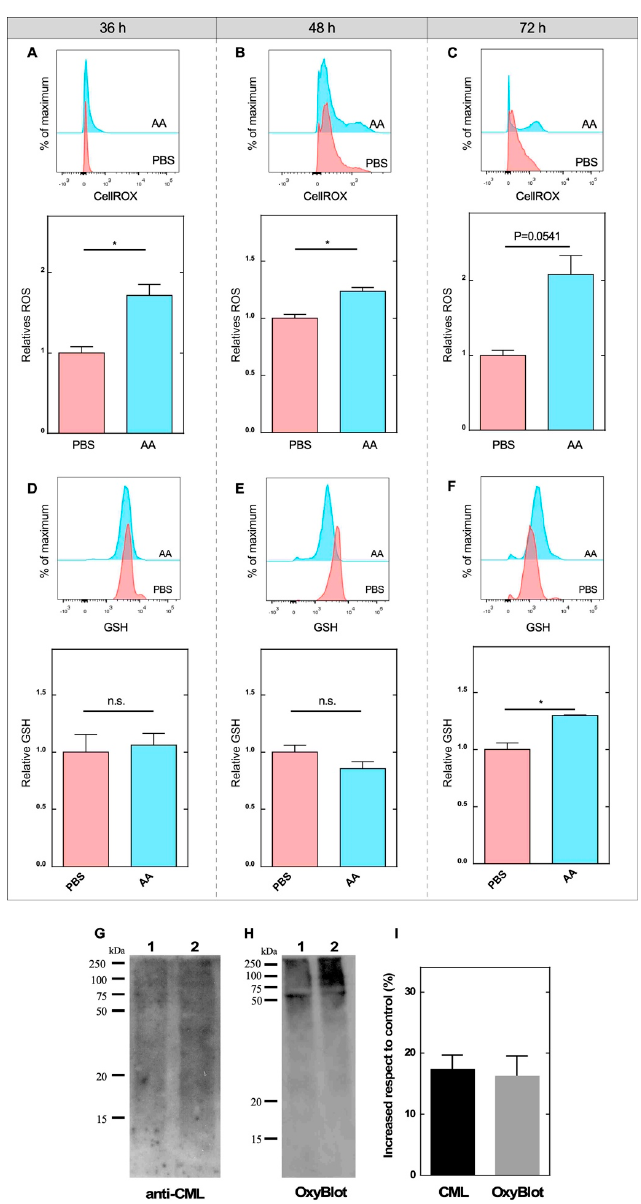
Figure 6. DHA accumulation impaired neurite outgrowth through redox imbalance. ( A – C ) Representative histogram of CellROX ® dye detection (APC channel) in control NEs (PBS, pink) and in NEs treated with 100 µ M AA (light blue) for 36 ( A ), 48 ( B ) and 72 h ( C ), respectively. Fluorescence intensity quantification of CellROX ® in the control (PBS) and treated (AA) conditions is shown at the bottom. All data are representative of three separate experiments. Student’s t -test was used, * p < 0.05. ( D – F ) Flow cytometry analysis was performed using ThioBrightTM Green probe for intracellular GSH detection in control NEs (pink) and in NEs treated with AA (light blue) for 36 h ( D ), 48 h ( E ) and 72 h ( F ). The representative histogram of the detection of the probe through the FITC channel (GSH) is shown at the top. The quantification of fluorescence intensity in control samples (PBS) compared to treated samples (AA) at di ff erent times analyzed is shown in the lower part. Analysis was performed on three independent experiments; 20,000 events were recorded per condition. Student’s t-test was used, * p < 0.05; n.s., not significant. ( G ) Carboxymethyl-lysine (CML) immunoblot detection in control NE samples (lane 1) and NEs treated with AA (lane 2). All data are representative of three separate experiments. ( H ) Oxy-Blot analysis of protein carbonylation in extracts from control NEs (lane 1) and from those treated for 72 h with 100 µ M AA (lane 2). All data are representative of three separate experiments. ( I ) Densitometry analysis of the CML and Oxy-Blot analyses is shown as a percentage of increase with respect to the control (PBS). All data are representative of three separate